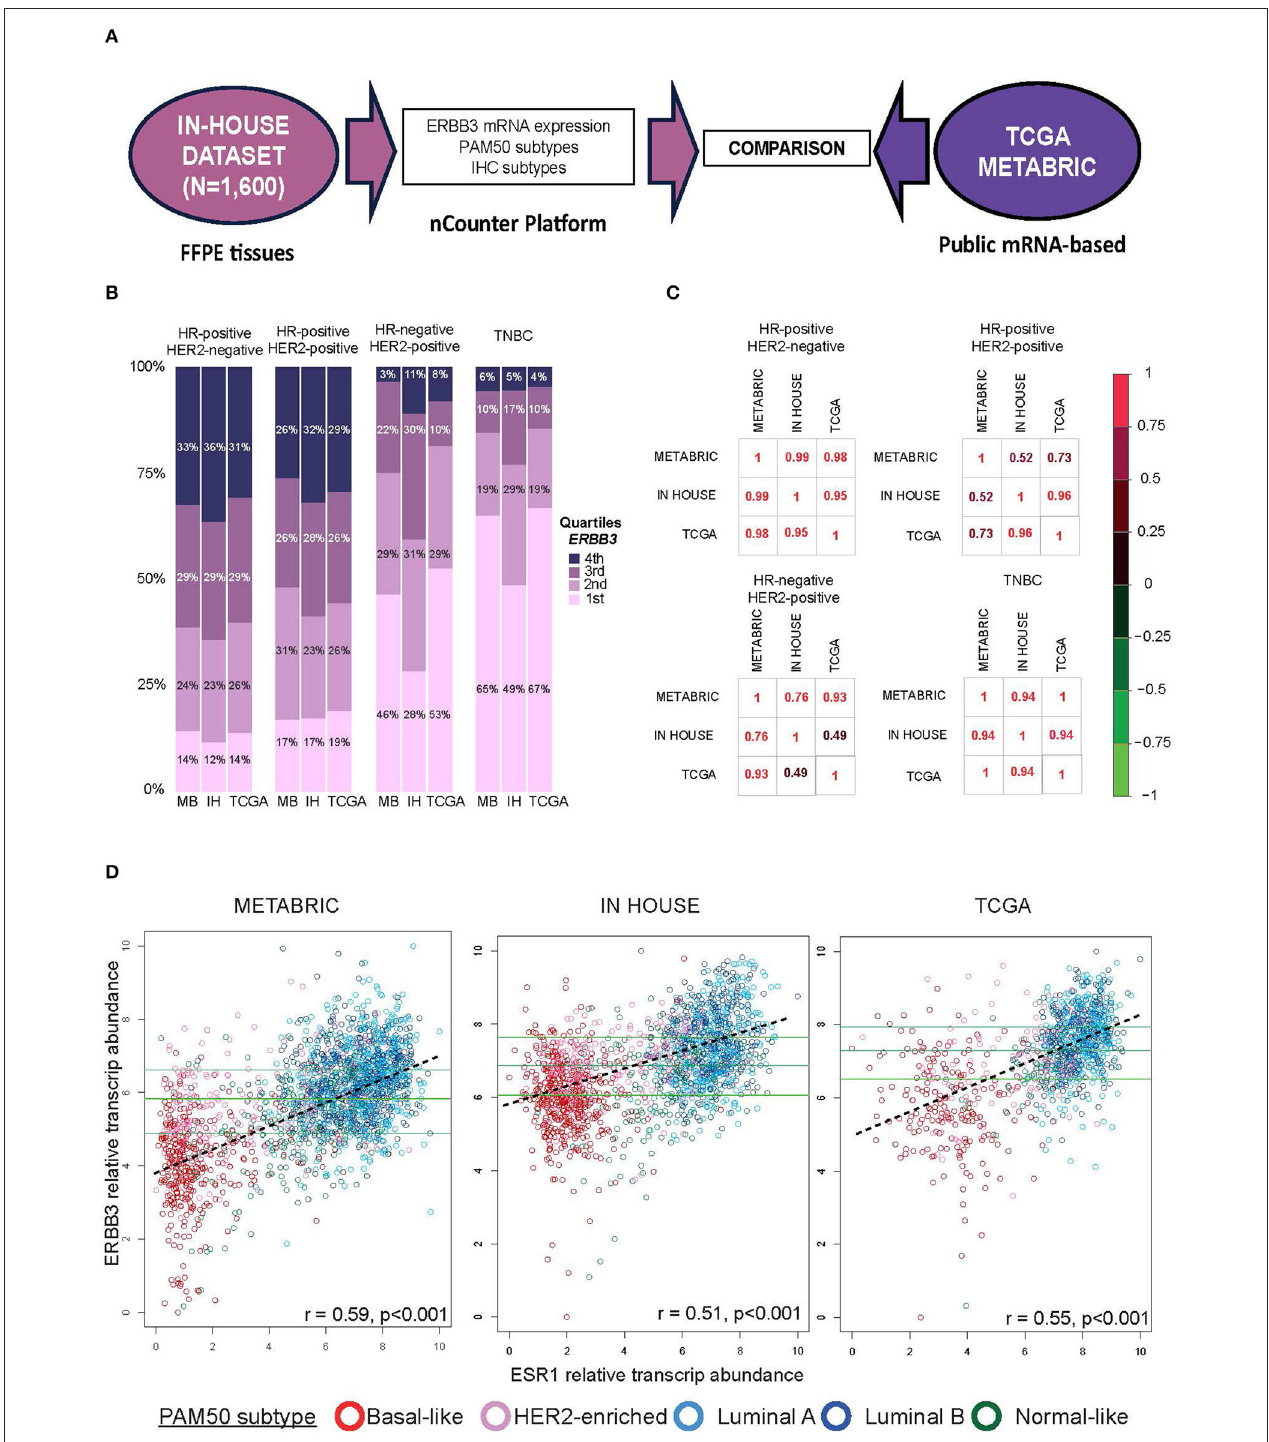
FIGURE 3 | Comparing ERBB3 expression across datasets (A) Evaluation of ERBB3 cutoff in breast cancer samples from patients with early breast cancer included in IN-HOUSE, METABRIC, and TCGA. (B) Proportion of samples in each immunohistochemistry subtype based on the ERBB3 cohort. Each bar is colored according to the ERBB3 distribution in each cohort. (C) Correlation coefficients of proportions of tumor samples within each quartile based on the IHC subtype between the three datasets. (D) Scatter plots of ERBB3 vs. ESR1 expression for samples from METABRIC, IN-HOUSE, and TCGA cohorts, colored by subtype. The three horizontal lines indicate the cutoffs of each cohort. Discontinued line in each figure represents the regression line. Pearson correlation coefficient (r) with significance ( p- value) is presented in each figure.